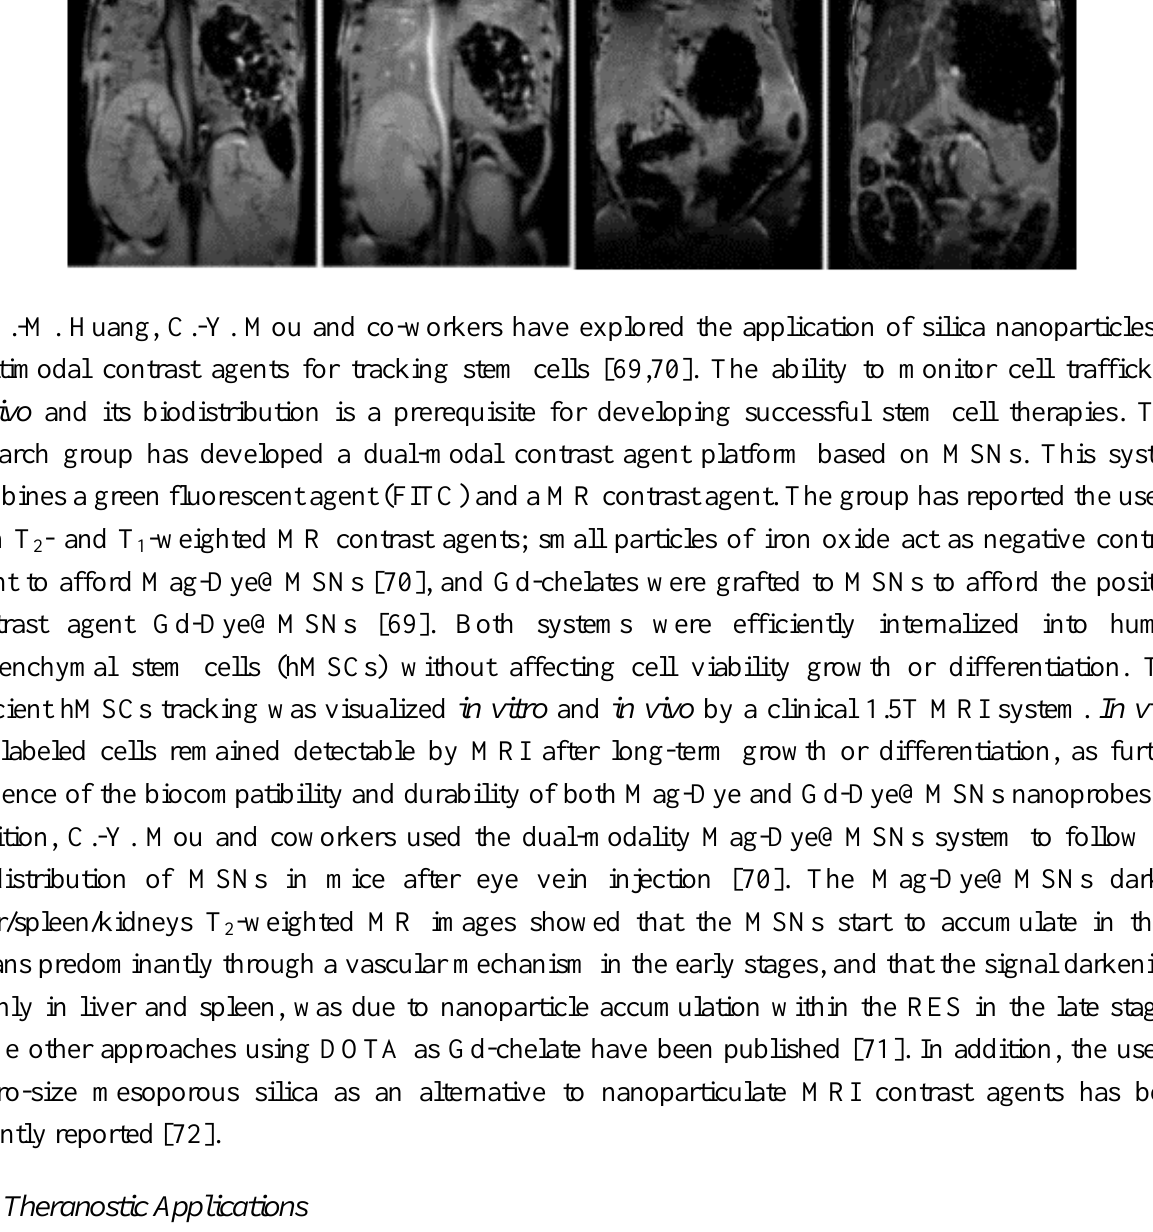
-weighted mouse MR 1 -weighted enhancement. 2